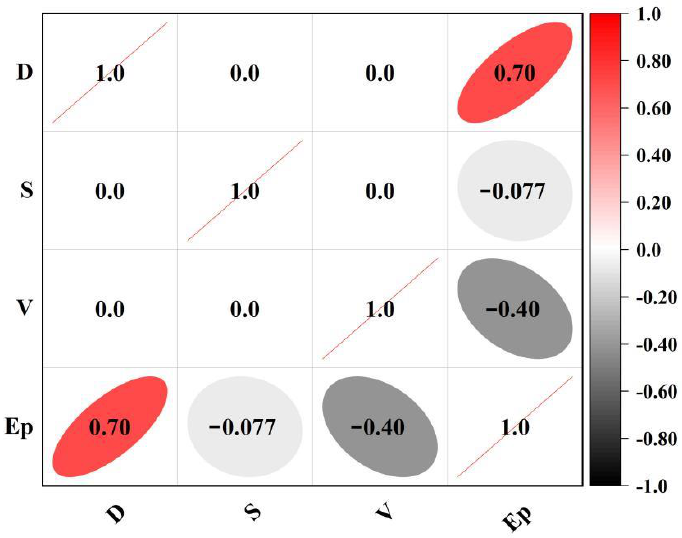
Figure 4. Correlation coefficient